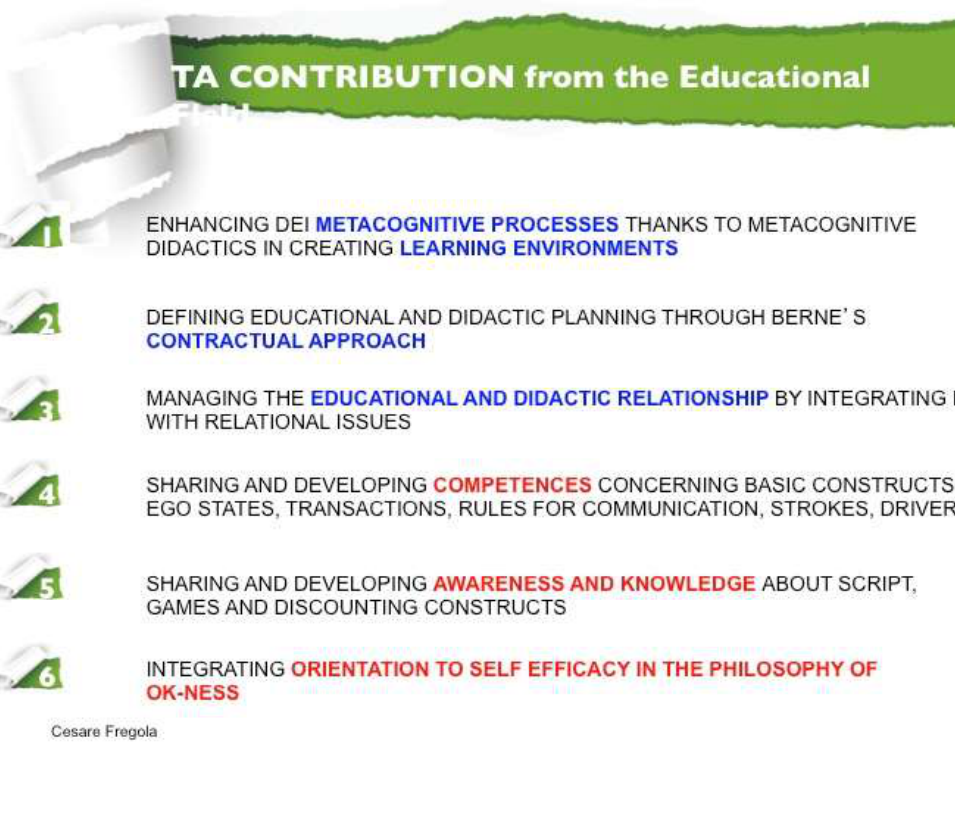
Figure 2: large scale contents of TA training integrated with teaching and learning processes, which are being developed in the field of training for educational and training